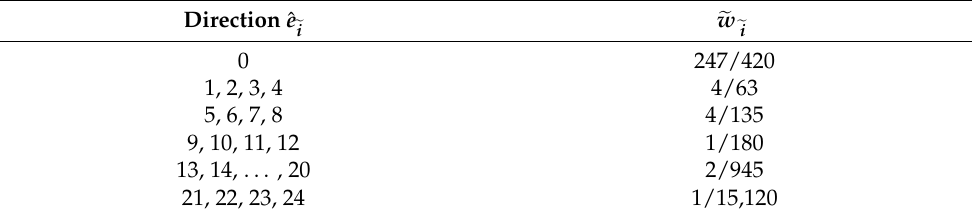
values for the D2Q25 (cid:101) i